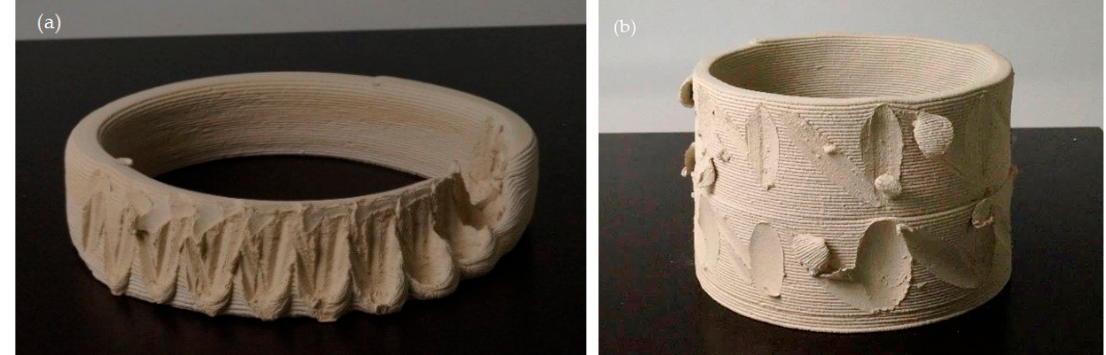
Figure 5. Comparison blurring artefact with the nozzle ( a ) and with the cutting tool ( b ).